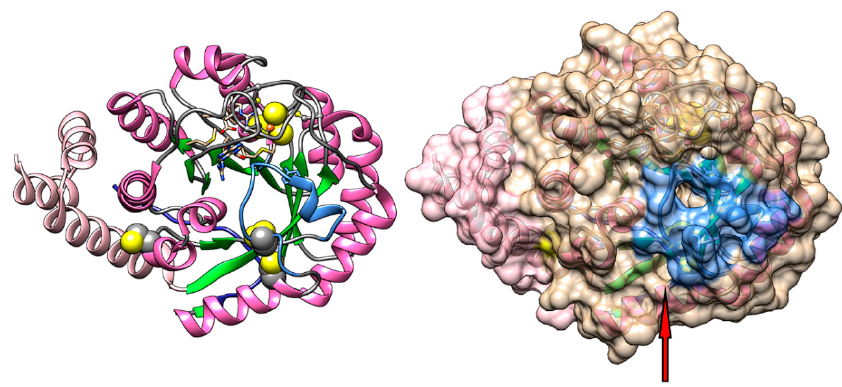
Figure 2. HydE (pdb.id 3CIW) from T. maritima. Left, cartoon representation of the protein, showing the protein from the top of the internal cavity. In magenta (helix) and green (strand) the TIM-barrel fold; in pale pink the N -terminal helices; in dark blue (on the other side of the protein) the C -terminal loop; in light blue the putative “lid” region governing the access to the active site; the [4Fe-4S] cluster forming the active site is in sphere representation; and the cysteine residues not binding the cluster are also in sphere representation. Right, same view as before but with the surface shown: the accesses to the internal cavity are in the center of the light blue zone and close to the two cysteines as shown by the red